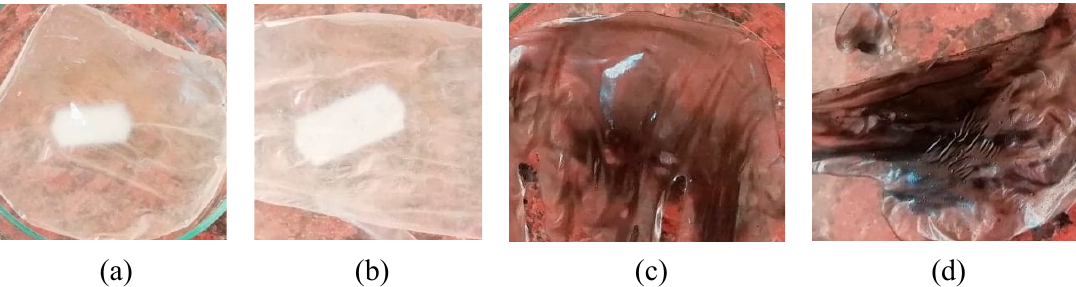
Figure 1. Digital photos of the samples: ( a ) chitosan (CS) film, ( b ) chitosan/ethylenediaminetetraacetic acid (CS/EDTA) film, ( c ) chitosan/ethylenediaminetetraacetic acid/graphene oxide (CS/EDTA/GO) film 0.1%, and ( d ) CS/EDTA/GO film 0.3%.